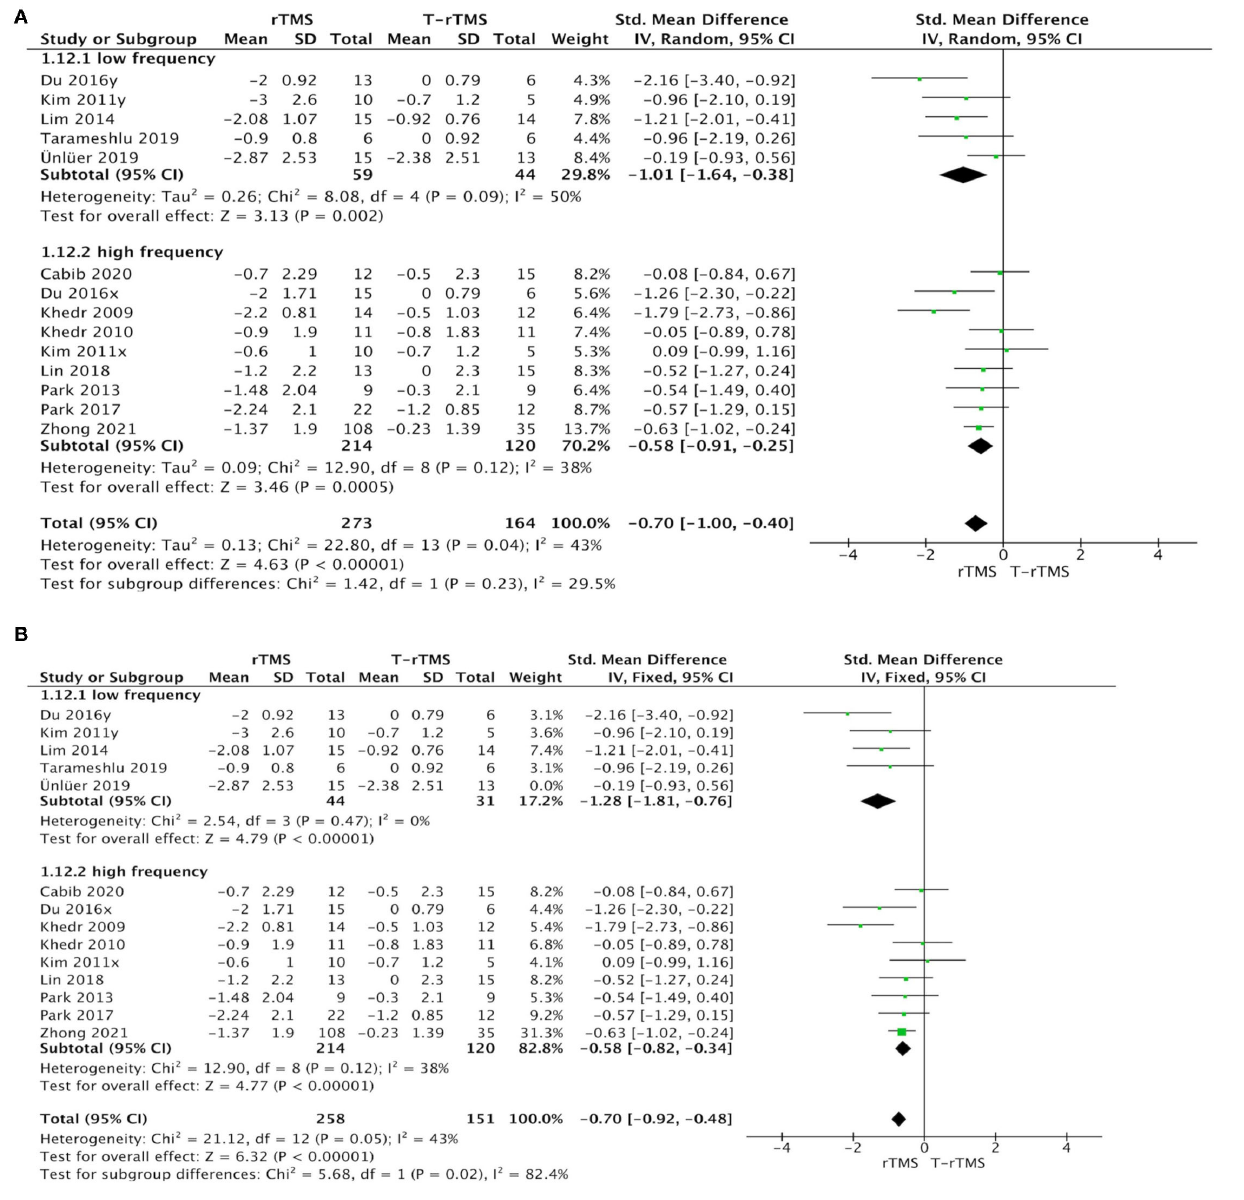
FIGURE 5 | Subgroup analysis of primary outcomes. (A) Forest plot of the standardized mean difference (SMD) for change scores in dysphagia severity rating scales by the stimulation frequency. (B) Sensitive analysis (excluded the Ünlüer et al.,